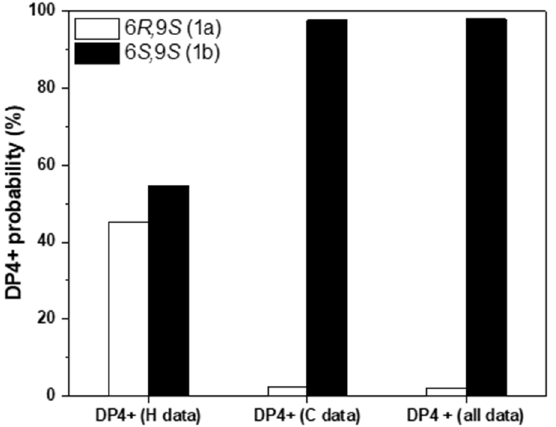
Figure 2. qccNMR coupled with DP4+ probability analysis of compound 1 for the stereo isomers 1a (9 R ,9 S , white) and 1b (6 S ,9 S , black).